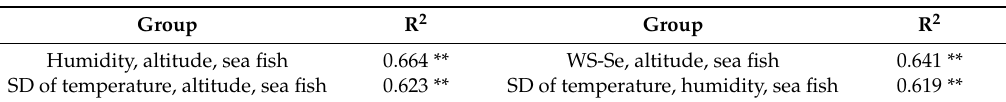
Table 6. Regression coefficient of the top four groups with highest R 2 (Regression coefficient) of geographically weighted regression (GWR) in 2000.